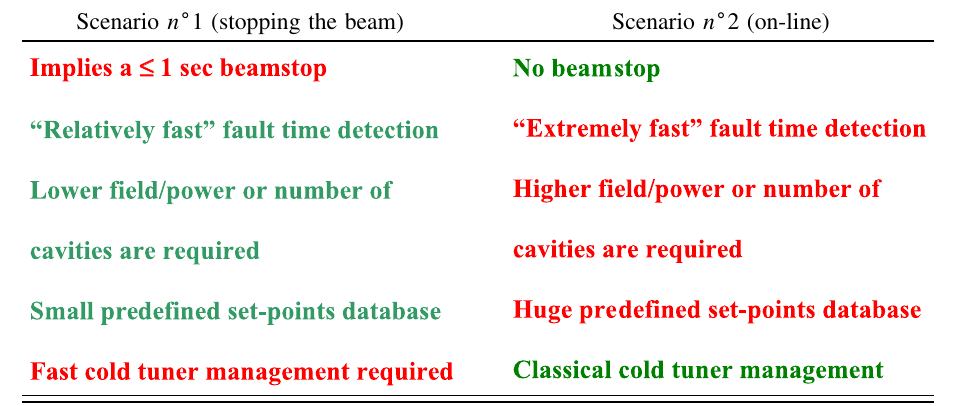
DYNAMIC COMPENSATION OF AN RF CAVITY FAILURE . . TABLE III. Requirements and features of the two fault-recovery scenarios. Scenario n (cid:4) 1 (stopping the beam) Scenario n (cid:4) 2 (on-line)